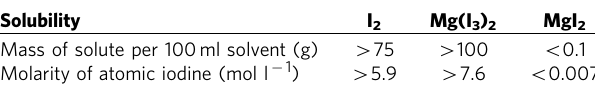
Table 1 | Solubility of different iodine species in tetraglyme.